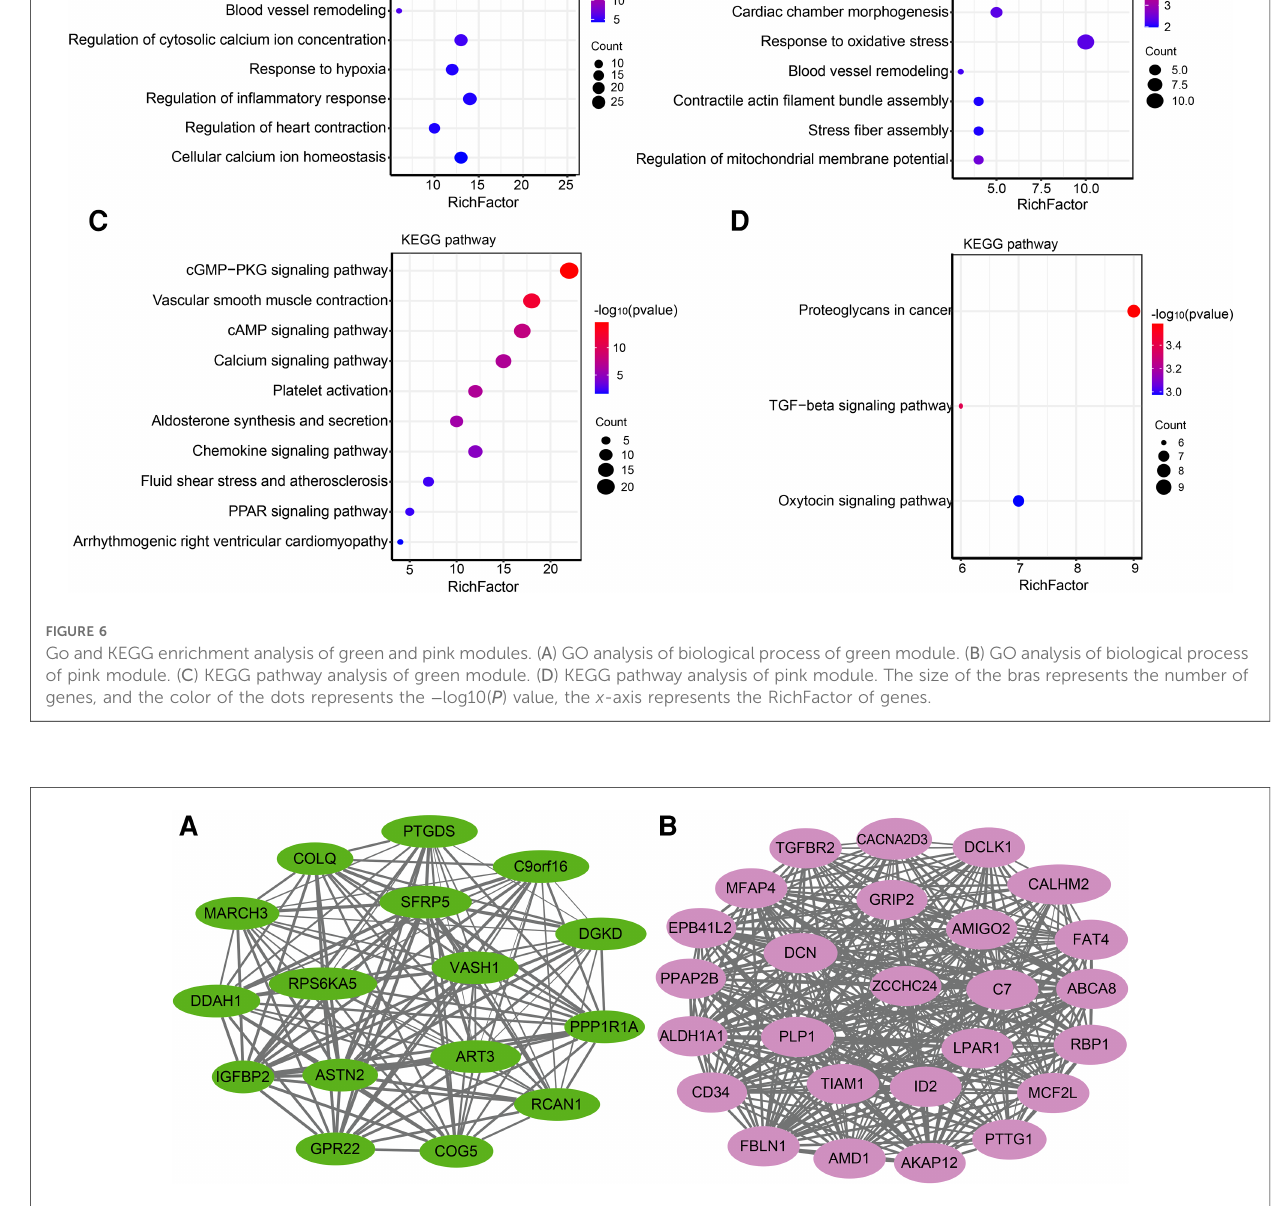
FIGURE 7 Hub gene map of the green module ( A ) and pink module ( B